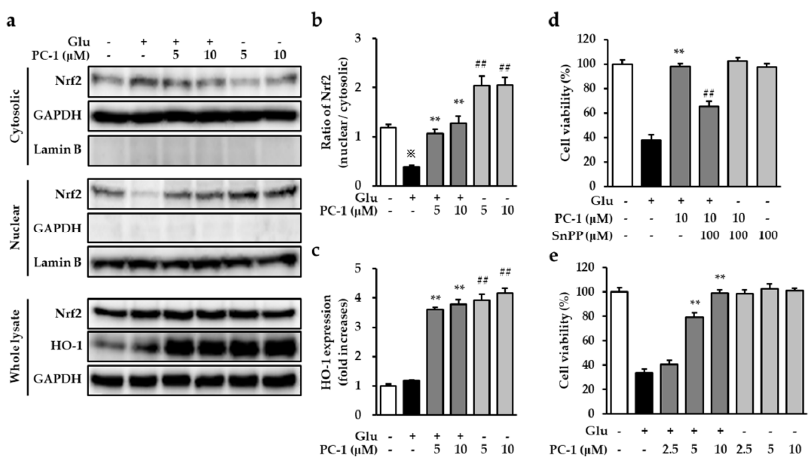
Figure 5. Procyanidin C1 increases the Nrf2 / HO-1 pathway in HT22 cells. ( a ) HT22 cells were exposed to 5 mM glutamate in the presence or absence of 5 or 10 µ M PC-1 for 6 h and western blot analysis was performed using Nrf2, HO-1, Lamin B, and GAPDH antibodies. The GAPDH and Lamin B were used as markers for cytosolic and nuclear fractions, respectively. ( b ) Bars indicate the ratio of nuclear Nrf2 to cytosolic Nrf2 indicating the nuclear translocation. Data are presented as the mean value ± S.E.M. ※ p < 0.001 versus control cells, ** p < 0.001 versus glutamate-treated cells, and ## p < 0.001 versus control cells. ( c ) Bars denote the fold-increases of HO-1 expression. Data are presented as the mean value ± S.E.M. ** p < 0.001 versus glutamate-treated cells, and ## p < 0.001 versus control cells. ( d ) The cells were treated with 100 µ M SnPP and 10 µ M PC-1 followed by the treatment with 5 mM glutamate, and the viability of cells were determined. Data are presented as the mean value ± S.E.M. ** p < 0.001 versus glutamate-treated cells and ## p < 0.001 versus cells treated with glutamate and PC-1. ( e ) After the pre-treatment with PC-1 for 4 h, cells were treated with 5 mM glutamate for 24 h. Data are presented as the mean value ± S.E.M. ** p < 0.001 versus glutamate-treated